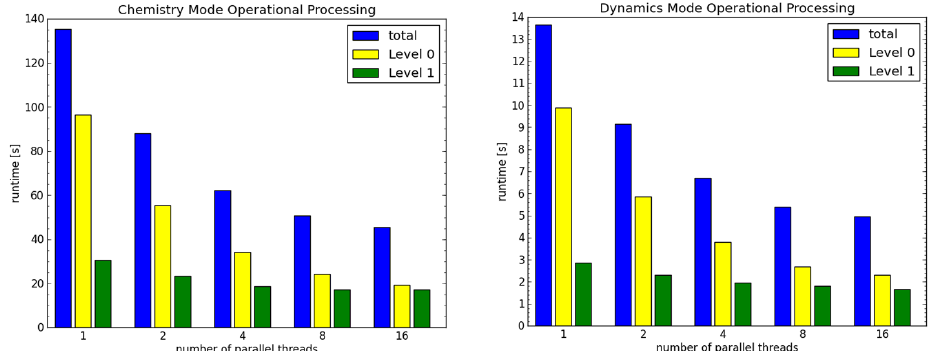
Figure 1. Runtime for the automated L0/L1 processor for different levels of parallelisation. In order to eliminate the influence of file input/output, the raw data were read from and the calibrated spectra written to a memory-based file system. Note that the L0 runtime as shown here encompasses the entire L0 processing stage, including the interferogram alignment correction. Earlier analyses of the operational L0 processor (Kleinert et al., 2014) showed the runtime for single execution.